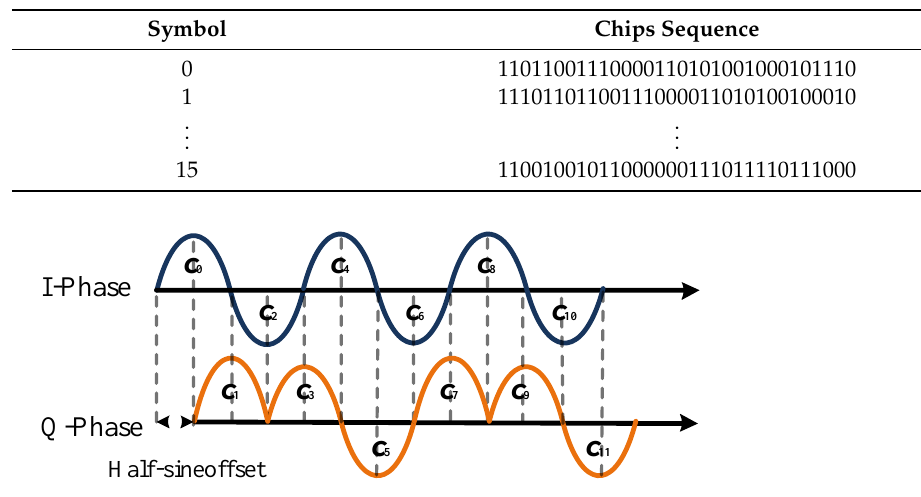
Table 1. IEEE 802.15.4 Chips Sequence.